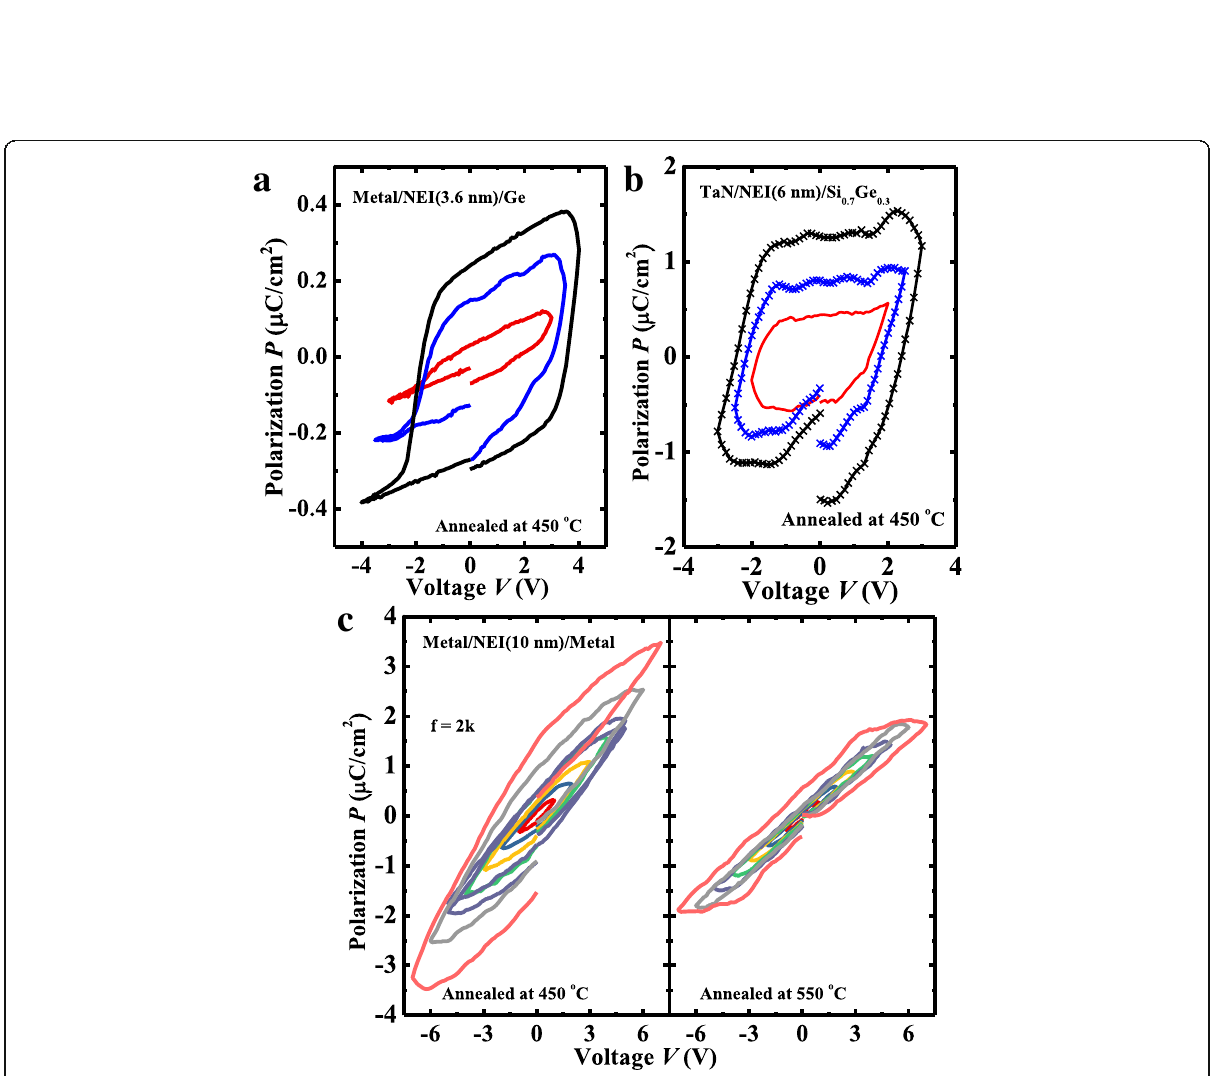
Fig. 4 a – c Measured P - V curves of TaN/NEI (3.6 nm)/Ge, TaN/NEI (6 nm)/Si 0.7 Ge 0.3 , and TaN/NEI (10 nm)/TaN,